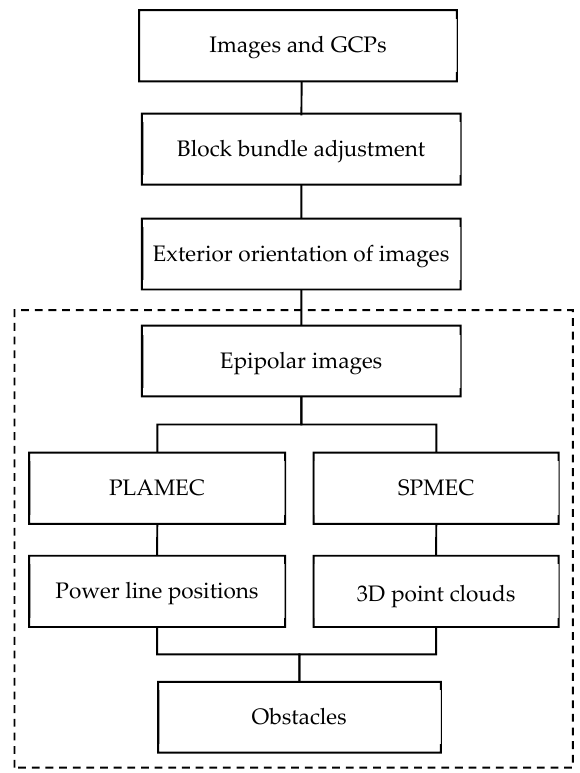
Figure 1. The workflow for the automatic detection of obstacles in power line corridors.